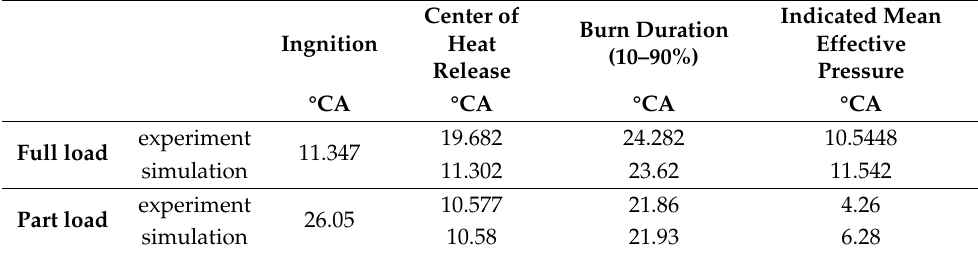
Table 1. Comparison of combustion parameters between experimental measurement and simulation for model